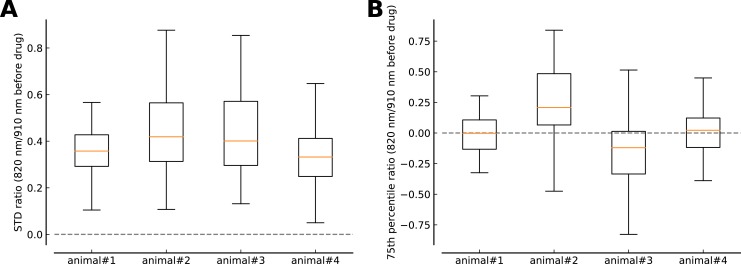
Comparison of fluorescence fluctuations and level during the recordings at 820 nm excitation wavelength with respect to the runs at 910 nm.(A) Ratio of fluorescence standard deviations (STD) during the locomotion period (t∈(10,25 s) between recordings at 820 and 910 nm laser excitation wavelength. Individual ratios are calculated for ROIs which have been recorded, aligned and matched (>30% overlap, see Materials and methods) between the two laser excitation conditions. The box-plots (median: orange; quartiles: box; range of data excluding outliers: whiskers) summarize the ratios for all ROIs recorded in one animal. (B) Same depiction as in (A) but for ratio of fluorescence 75th percentiles during the locomotion period (t∈(10,25 s) between recordings at 820 and 910 nm laser excitation wavelength.